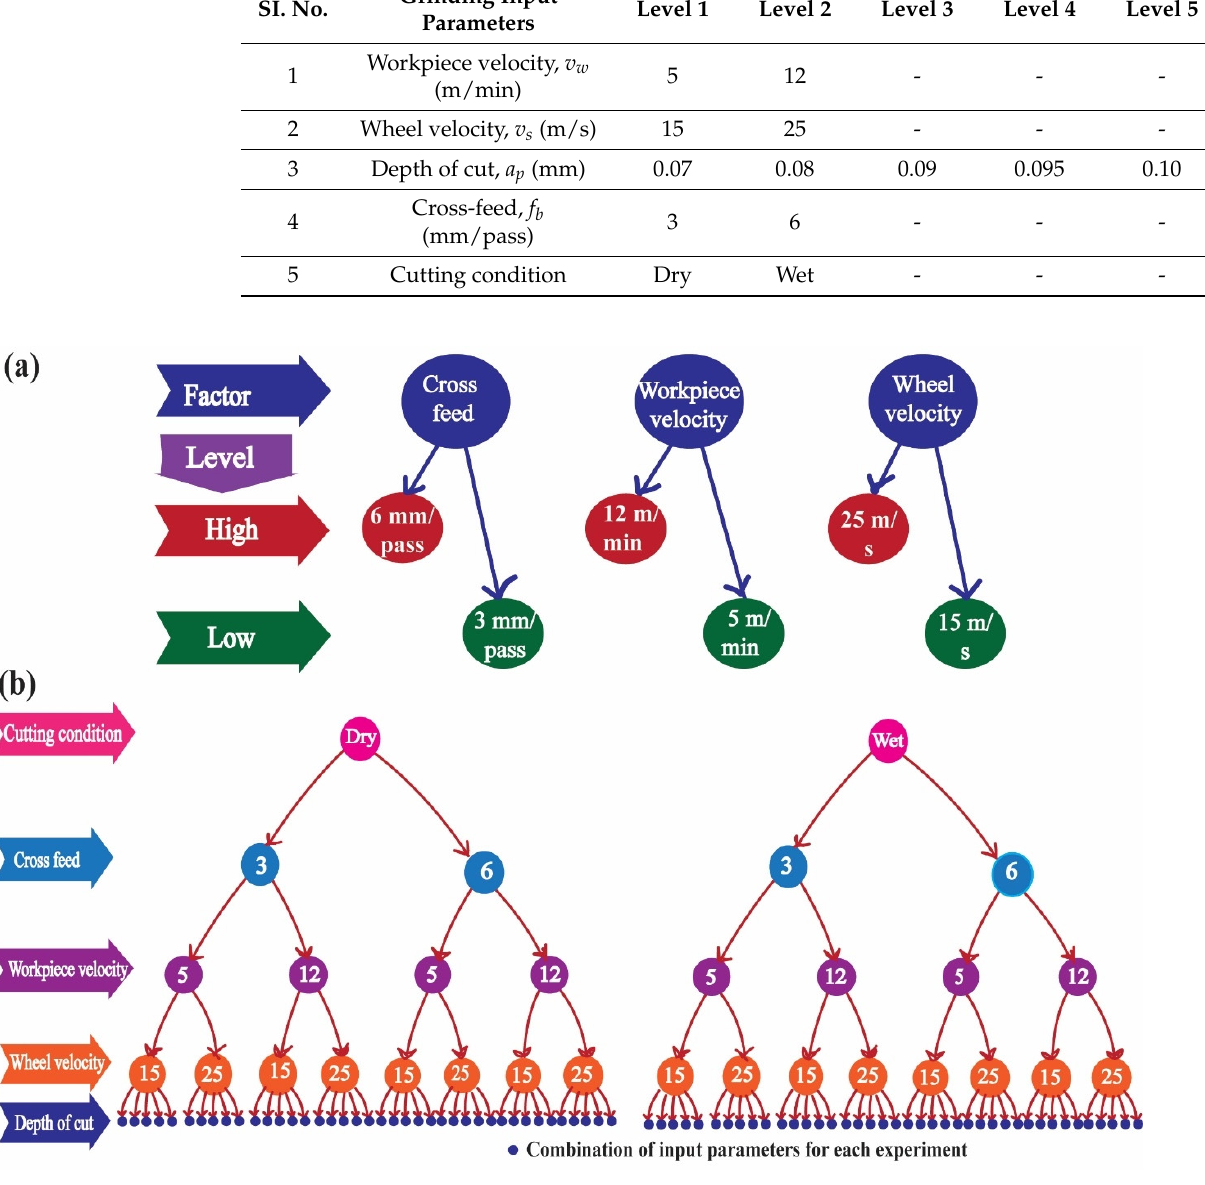
Figure 2. A schematic diagram depicting the design of experiment (DOE) conducted for this re- search work. ( a ) shows high low level of the parameters and ( b ) shows the multilevel full factorial design (2 4 × 5 = 80) applied to run 80 experiments.